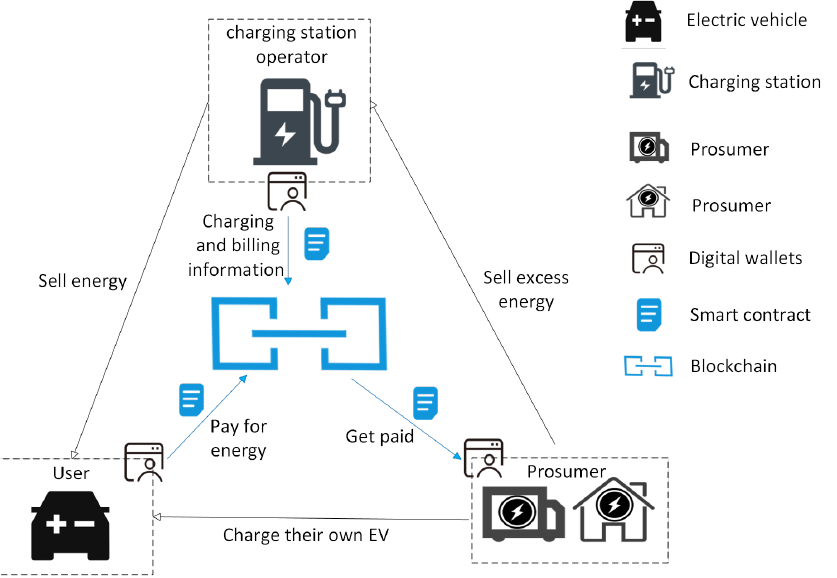
Figure 8. The working procedures of the blockchain-based p2p energy trading and charging payment system proposed in [104]. Table 3. Resource Sharing Related